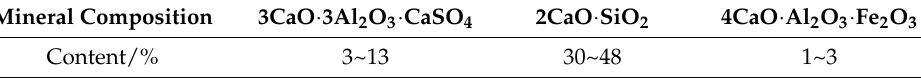
Table 6. Mineral composition of ingredient A. Mineral Composition